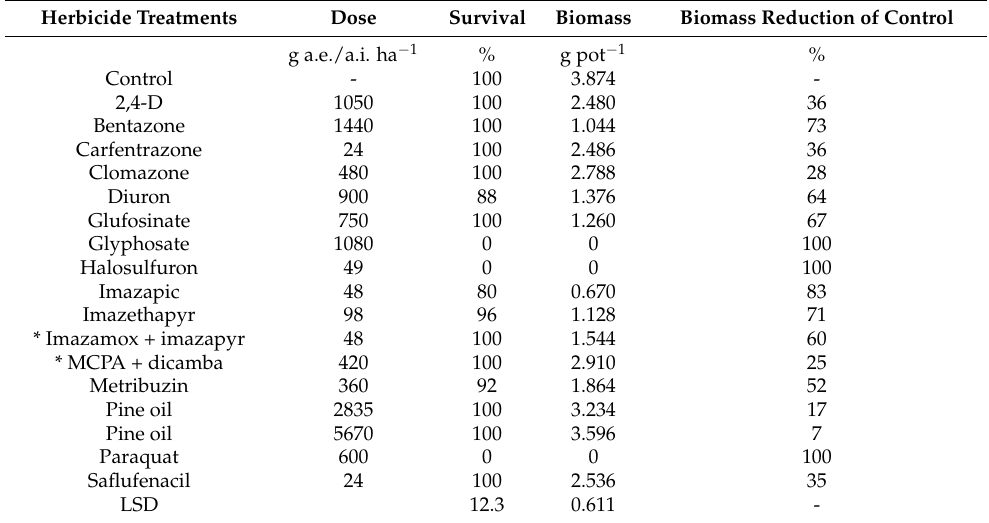
Table 2. The effect of herbicide treatments on the survival and biomass of Navua sedge when sprayed on 4–5 cm tall plants (6-leaf